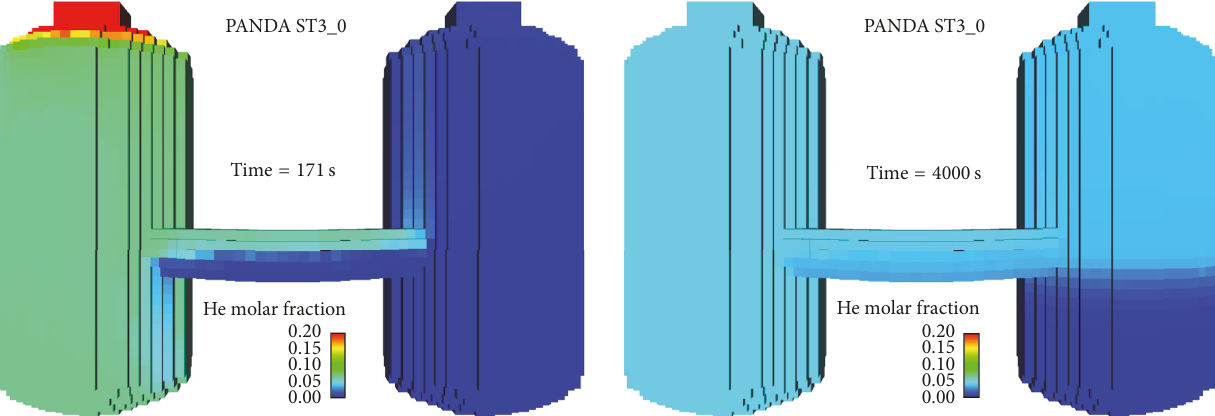
Figure 21: Helium concentration in ST3 0.